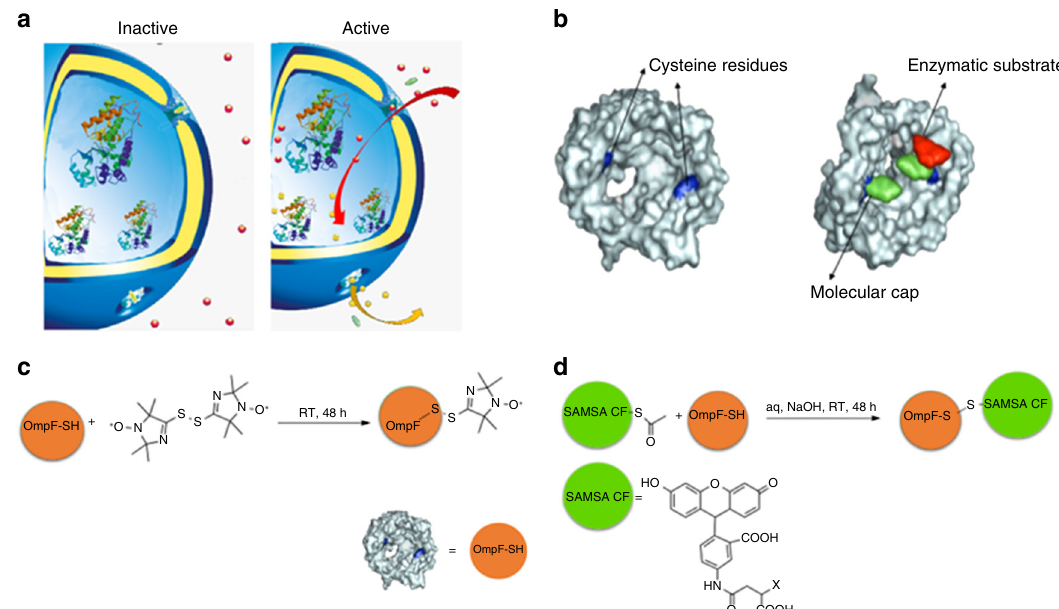
Fig. 1 Engineering stimuli-responsive OmpF. a Schematic representation of modi fi ed OmpF acting as a gate in catalytic nanocompartments. b Molecular representation of the OmpF-M cysteine mutant 37 . c Chemical modi fi cation of OmpF-M cysteine mutant with the spin probe bis-(2,2,5,5-tetramethyl-3- imidazoline-1-oxyl-4-yl) disulphide. d Chemical modi fi cation of OmpF-M cysteine mutant with the fl uorophore